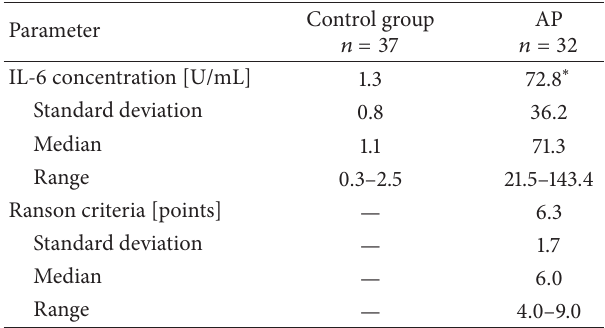
Table 1: IL-6 concentration and Ranson criteria as parameters describing the severity of acute